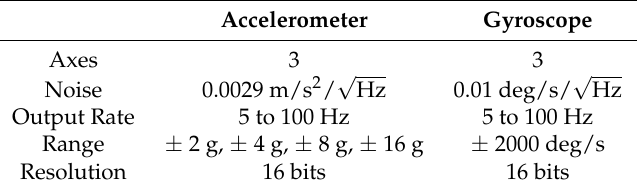
Figure 2. Placement of sensors at different body parts: ( a ) chest (smart phone); and ( b ) lower back (smart phone). Table 4. Technical specifications of MPU-6500